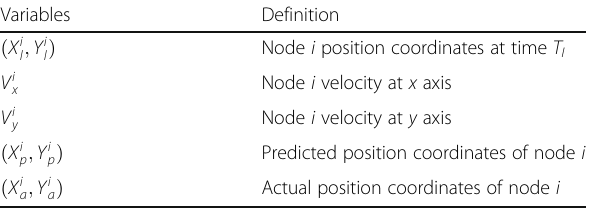
Table 1 Notations used for mobility prediction Variables